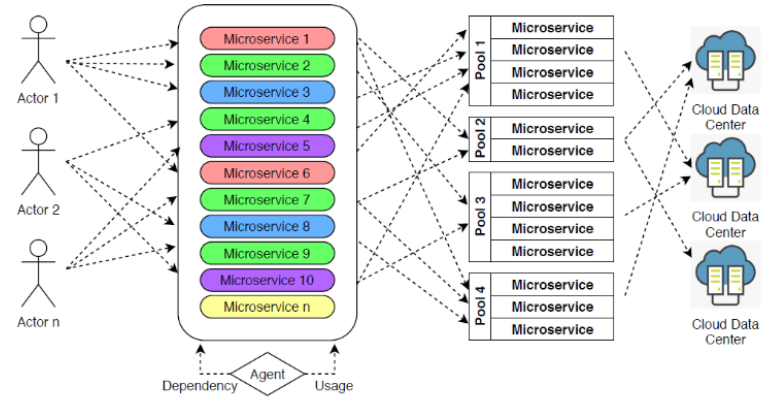
Figure 9. Schema for intelligent partitioning.